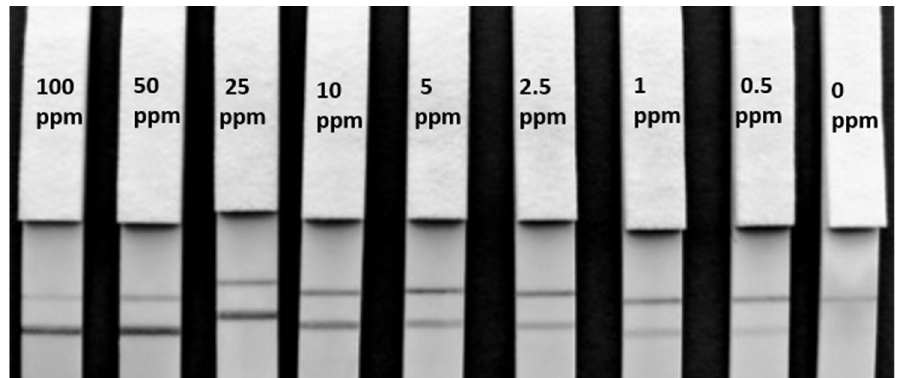
Figure 4. F- 50-6B12 Lateral flow immunoassay matrix limit of detection. Lateral flow strips for F-50-6B12 showing the matrix LOD of hazelnut protein extract spiked in blank cookie using 50 µL spiked sample and 50 µL RB. A clear LOD of below 0.5 ppm can be visualized both with the naked eye and with a smartphone camera.